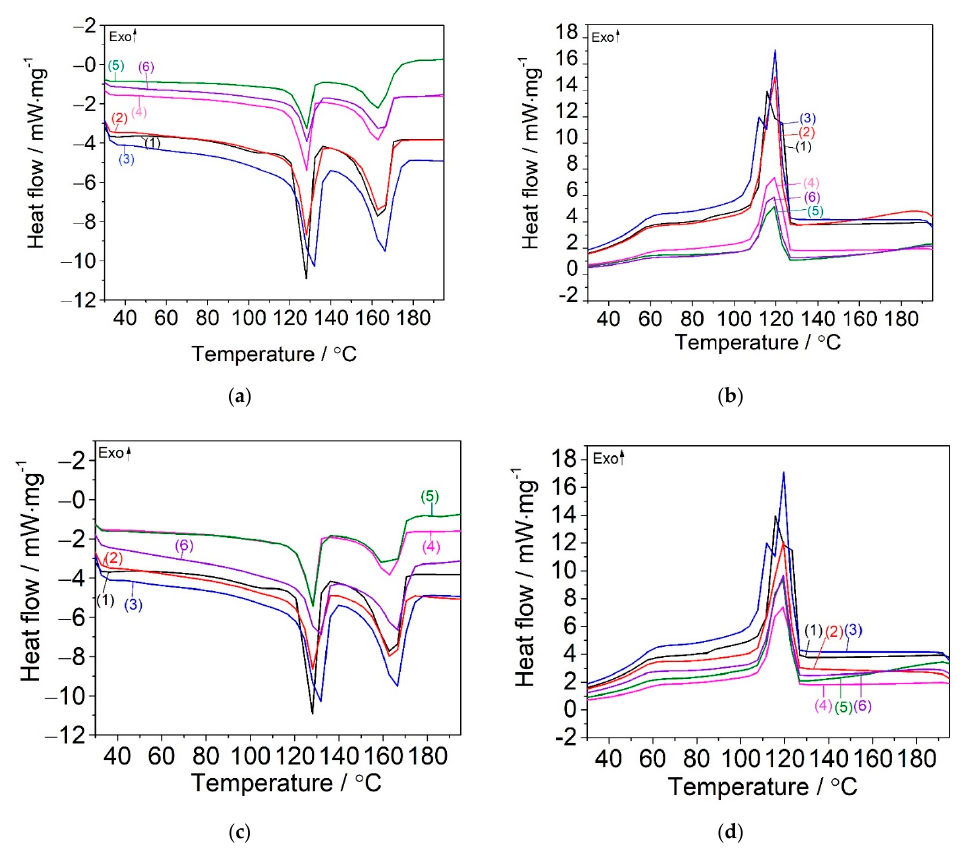
Figure 7. DSC curves of PPW (1), PPW/SBSBC (2), PPW/n-Clay 5% (3), PPW/n-Clay 10% (4), PPW/SBSBC/n-Clay 5% (5), PPW/SBSBC/n-Clay 10% (6) samples ( a ) melting and ( b ) crystallization steps; PPW (1), PWP/SISBC (2), PWP/n-Clay 5% (3), PPW/n-Clay 10% (4), PPW/SISBC/n-Clay 5% (5), PPW/SISBC/n-Clay 10% (6) samples ( c ) melting and ( d ) re-crystallization steps. Table 4. Thermal data of PPW/SBSBC, PPW/SISBC, PPW/SBSBC/n-Clay, and PPW/SISBC/n-Clay samples obtained from the first heating and cooling process.